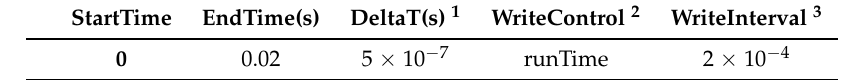
Table 4. fvSolution contains a series of sub-dictionaries to afford the necessary info for the solvers’